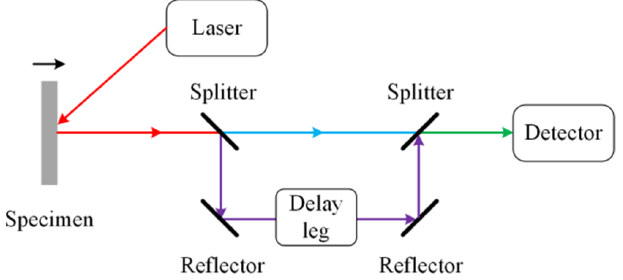
Figure 9. Schematic diagram of